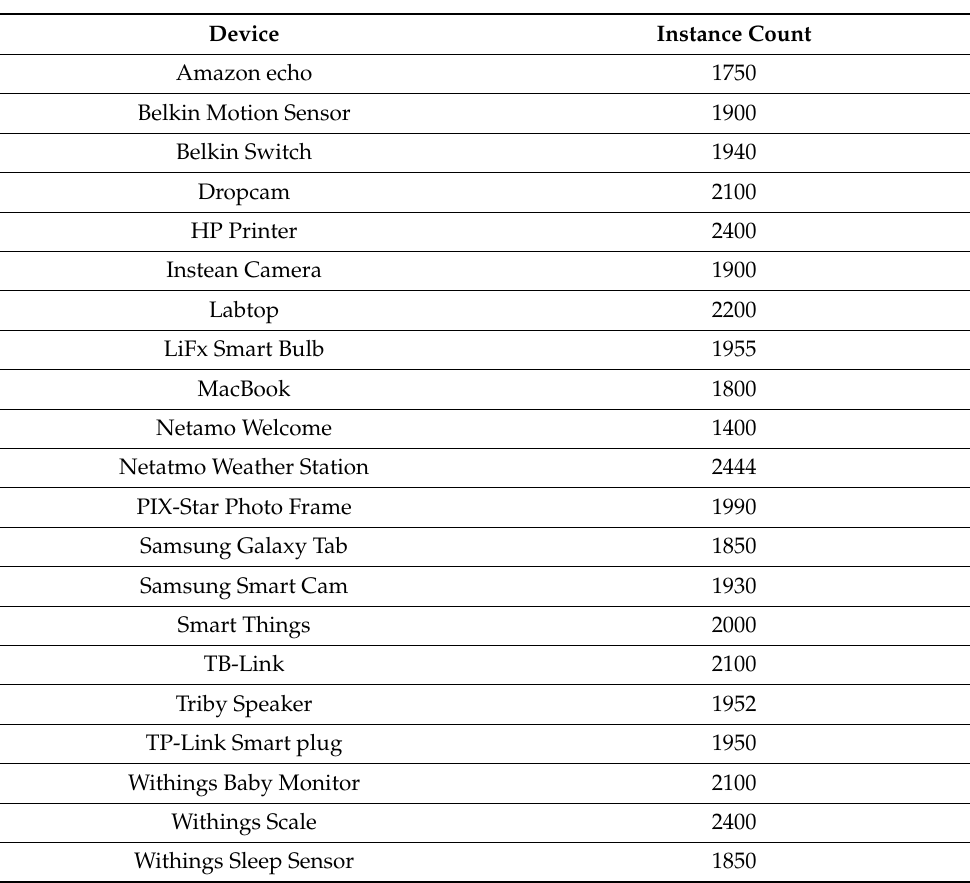
Table 6. Devices total instance